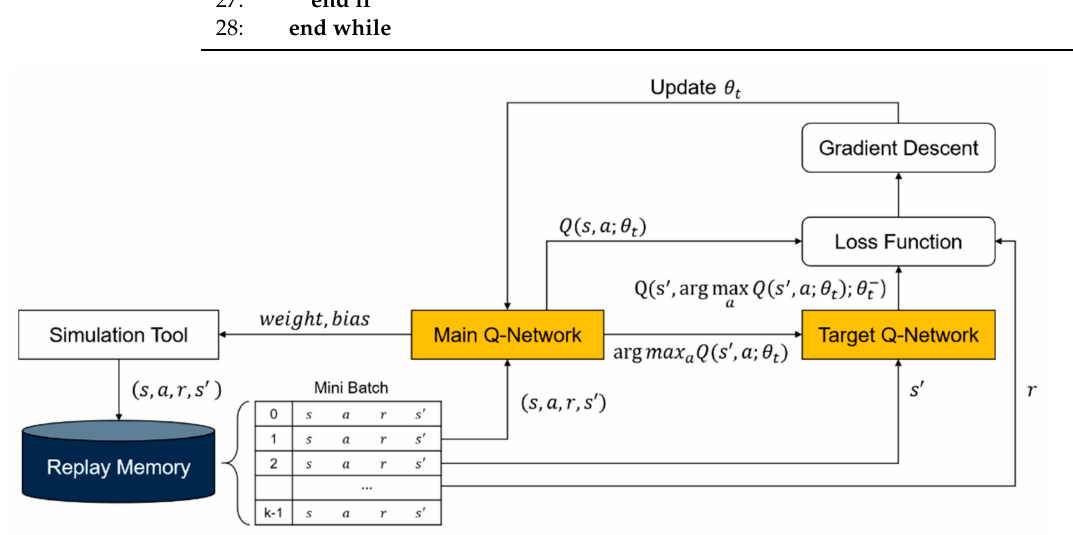
Figure 7. Storage of collected data in simulation model for